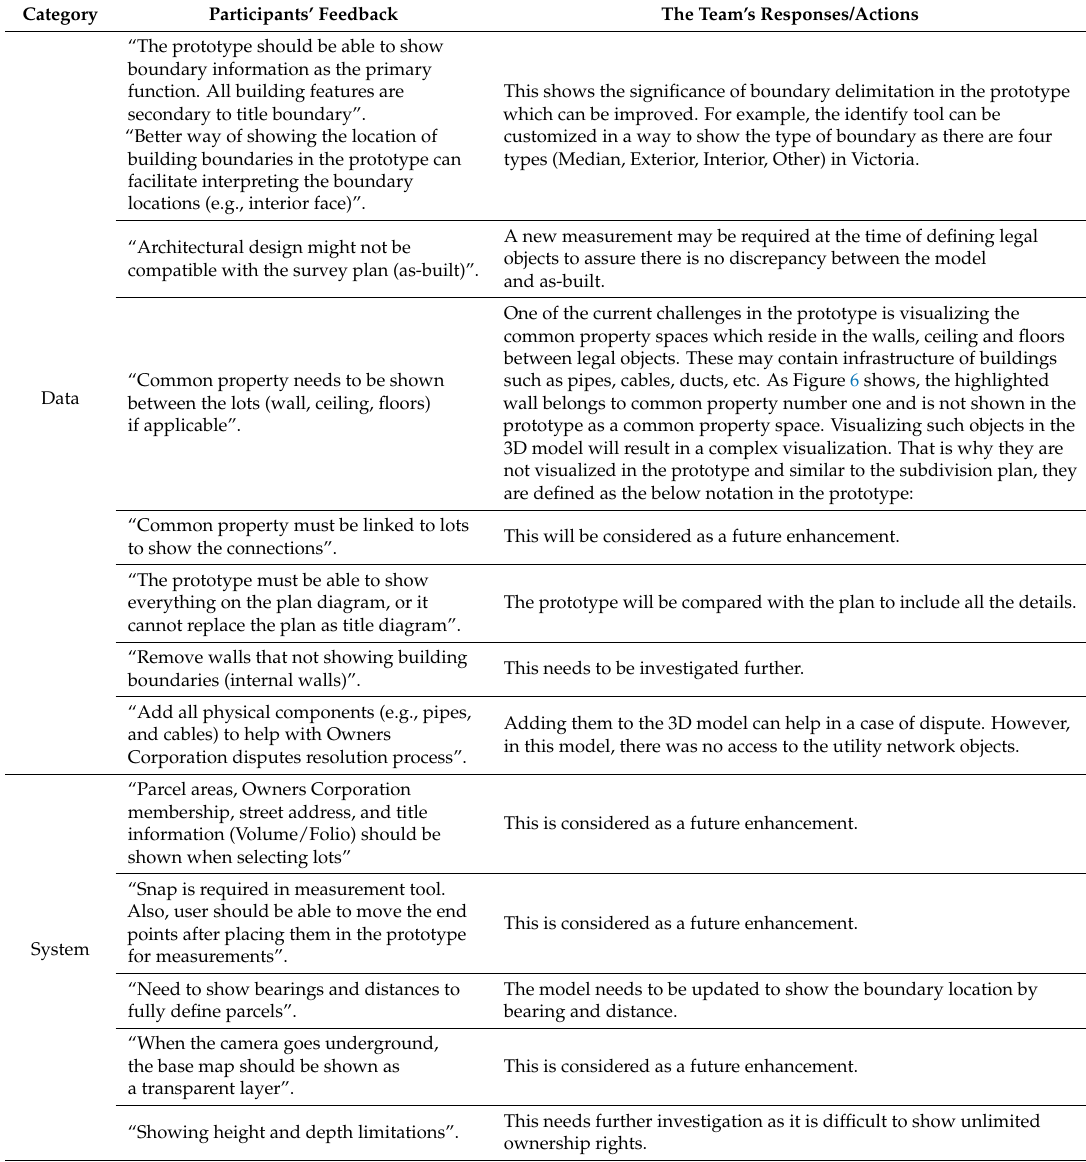
Table 3. The research team’s responses/actions to the participants’